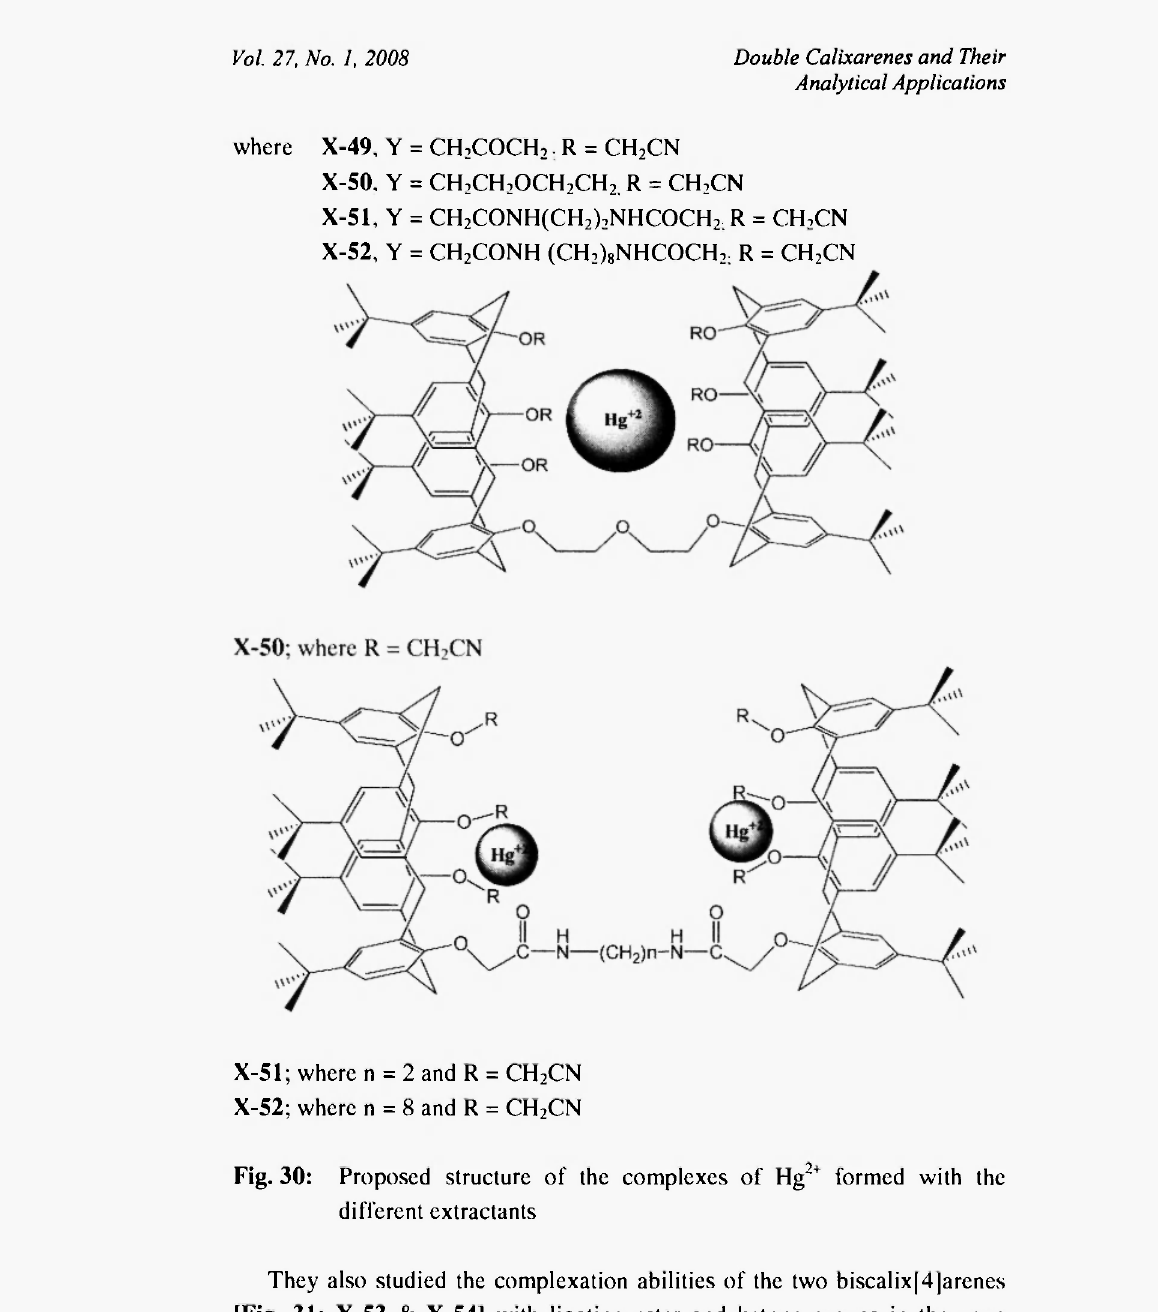
X-51; where η = 2 and R = CH 2 CN X-52; where η = 8 and R = CH 2 CN Fig. 30: Proposed structure of the complexes of Hg 2+ formed with the different extractants They also studied the complexation abilities of the two biscalix|4]arenes [Fig. 31; X-53 & X-54] with ligating ester and ketone groups in the cone conformation towards transition ( Ag 2+ , Hg 2+ Cu 2+ , Ni 2+ Co 2+ ,Cd 2+ ) metal ions /86/. They found that the ester derivative (X-53) showed a higher affinity toward transition metals than alkali metal cations, while the ketone